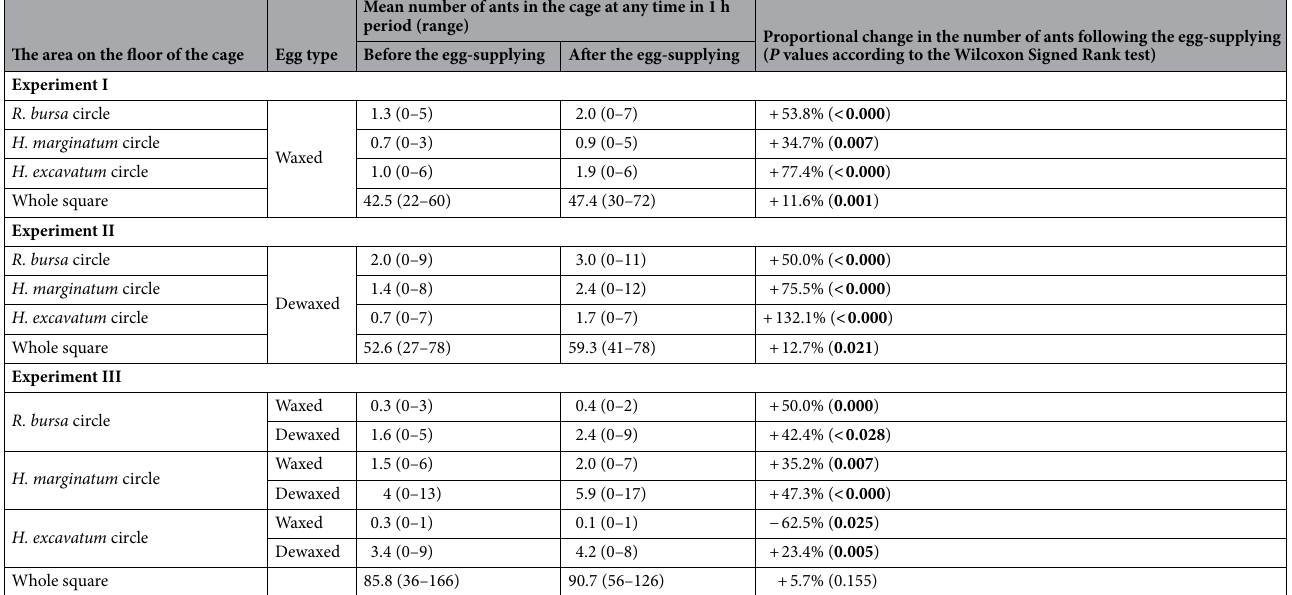
Table 3. The number of the ants in the cages at any time during the 1-h period before and after the egg- supplying. Significant values are in